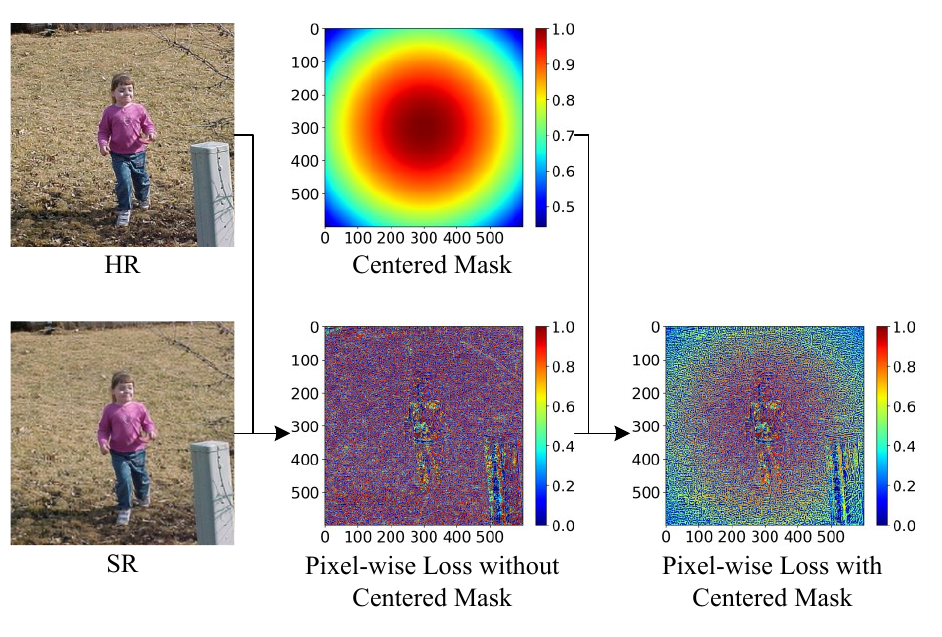
Figure 4. Centered